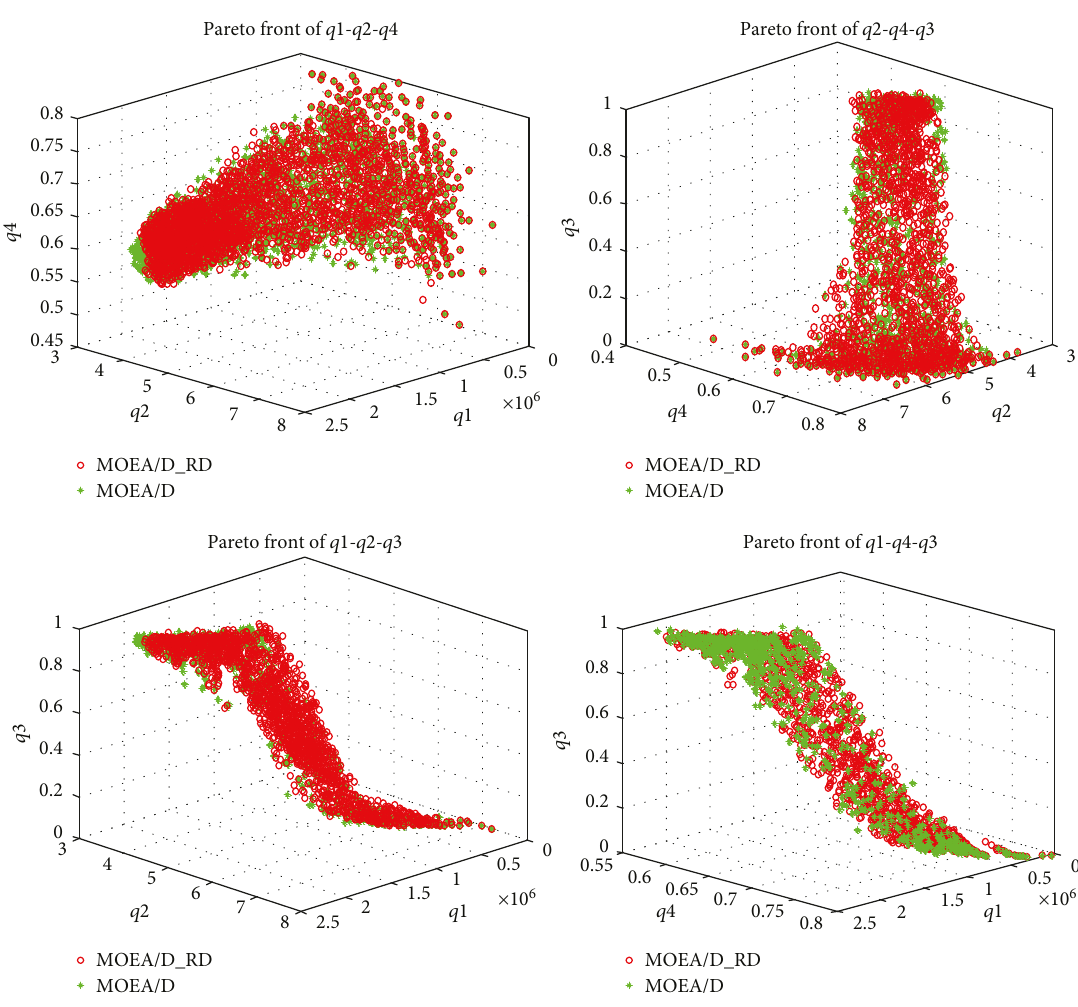
Figure 9: Comparison of PF between MOEA/D_RD (red circle) and MOEA/D (green ∗ ) for 3-objective